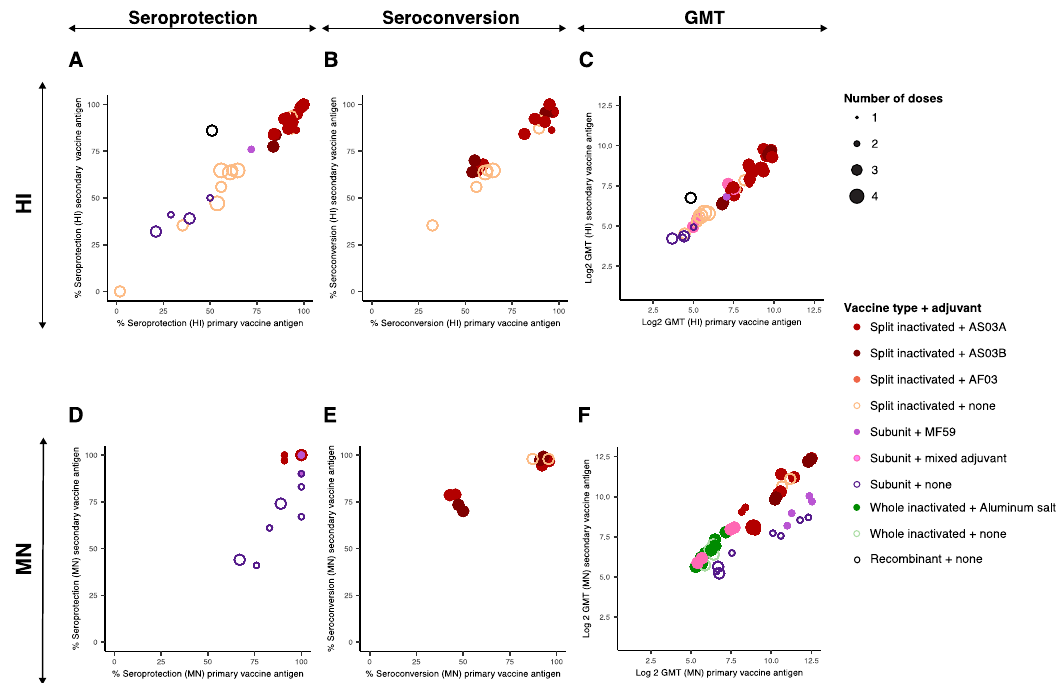
Figure 4. Immunological endpoints of heterologous vaccination strategies. Immunological endpoint values obtained against the antigen homologous to the primary vaccine strain (x-axis) are plotted against those obtained against the antigen homologous to the secondary vaccine strain (y-axis). Since the vast majority of experimental groups received heterologous vaccination(s) with the same vaccine type as the primary vaccination, the color and fill of the individual points indicate the vaccine type and adjuvant combination used in the primary vaccination according to the legend. The size of the circle indicates the number of vaccine doses (one to four) used before the serum sample was obtained as indicated on the right side of the figure. Data on persistence of the immune response was excluded. ( A ) Percentage seroprotected subjects measured by HI assay; ( B ) percentage of seroconverted subjects measured by HI assay; ( C ) Log2 of the geometric mean HI titer; ( D ) percentage of seroprotected subjects measured by MN assay; ( E ) percentage of seroconverted subjects measured by MN assay; ( F ) Log2 of the geometric mean MN titer. Abbreviations: HI: hemagglutination inhibition; MN: microneutralization; GMT: geometric mean titer.